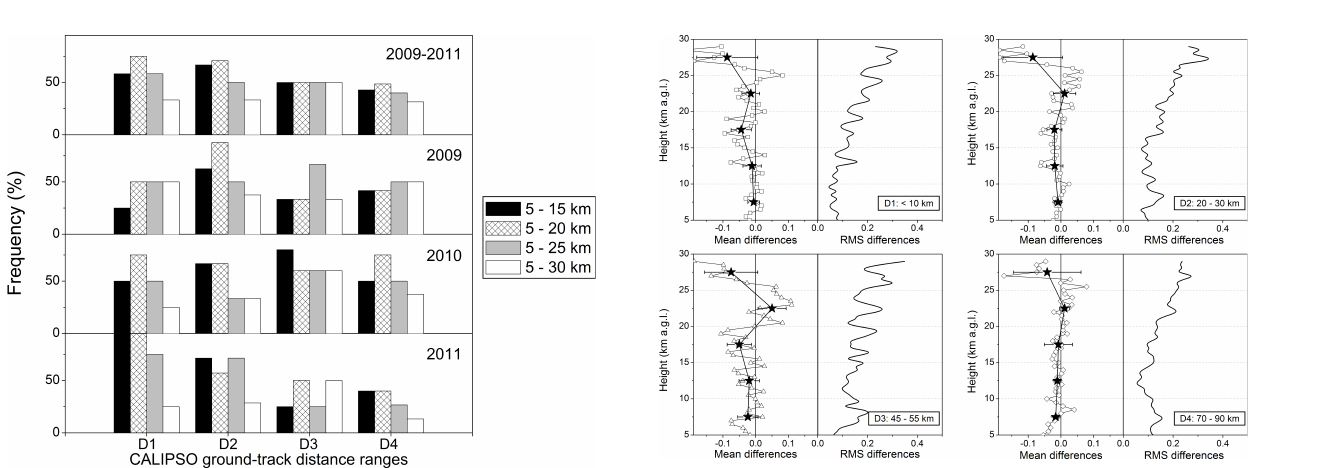
Fig. 5. Frequency (%) of correlation coefficients (CC) higher than 0.5 for four fitting height intervals (see legend) for the four predom- inant CALIPSO ground-track distances from Belgrano II station (D1: < 10km, D2: 20–30km, D3: 45–55km, and D4: 70–90km)